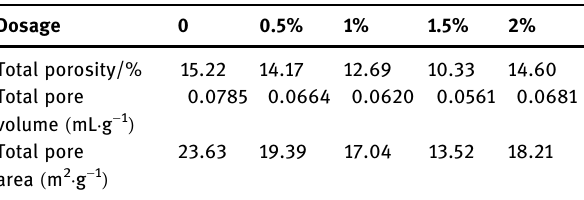
Table 1: Steel fi ber reinforced concrete pore structure para -